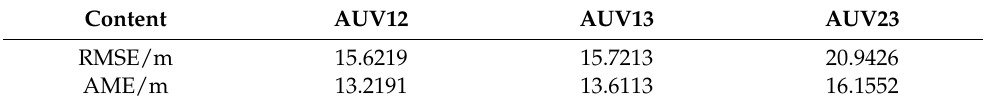
Table 3. Relative distance error statistics. Content